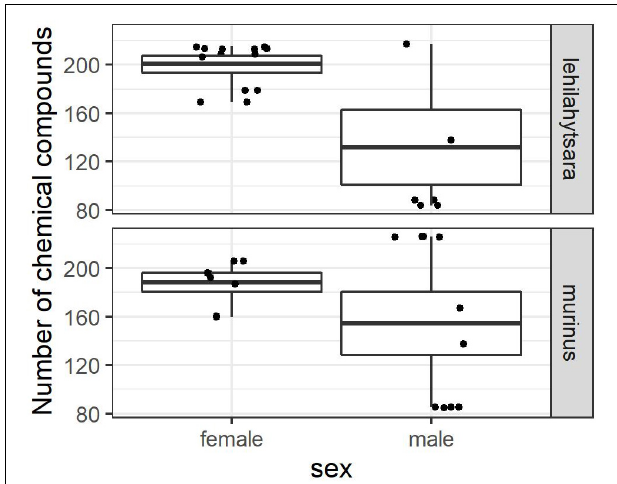
FIGURE 2 | Number of volatile compounds per individual sample for male and female M. lehilahytsara (upper panel) and M. murinus (lower panel) (Mean, box: standard error, whiskers: minimum and maximum value). Individual values are displayed as jitter. Male samples contained significantly less compounds than female samples in both species (see